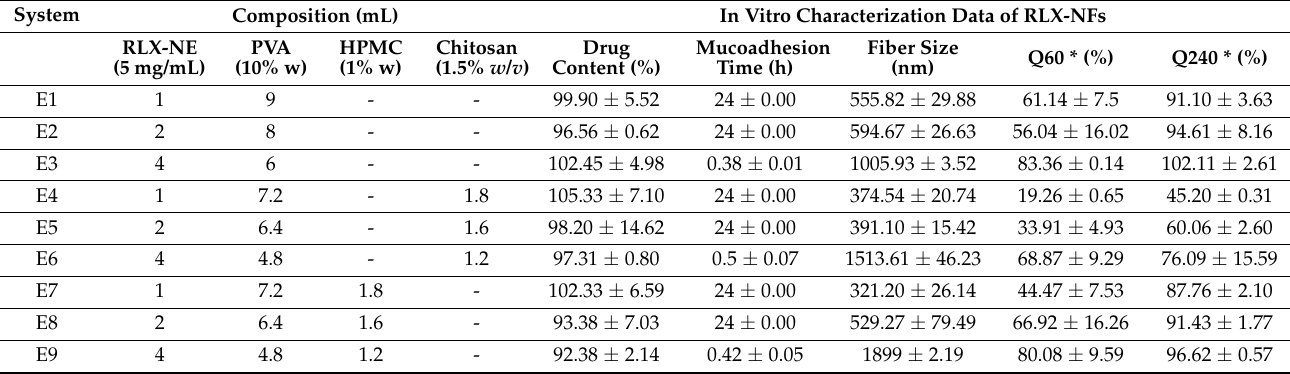
Table 1. The composition and in vitro characterization results (mean ± S.D., n = 3) of the developed raloxifene nanofibers.